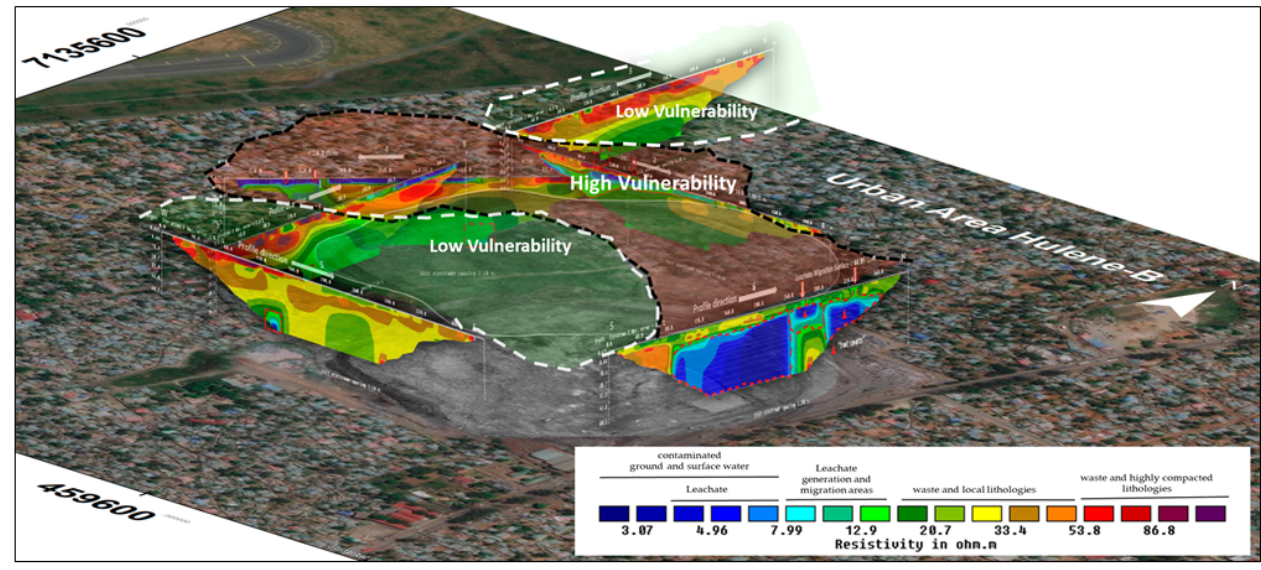
Figure 7. Spatial projection of the modified DRASTIC in surroundings of the Hulene ‐ B dump: dashed in white represents low vulnerability and in black high vulnerability.